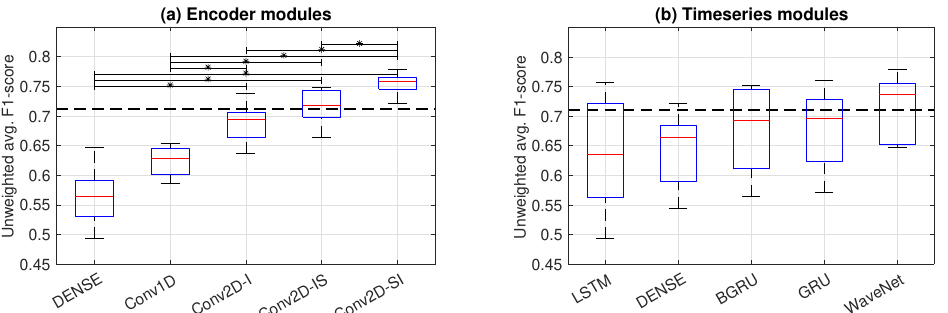
Figure 6. Pooled performance of encoder modules ( a ) and time series modules ( b ) as boxplots showcasing their range, interquartile range, and median. Statistically significant differences (Wilcoxon rank sum test; p < 0.05) between the average effect of the modules are marked with